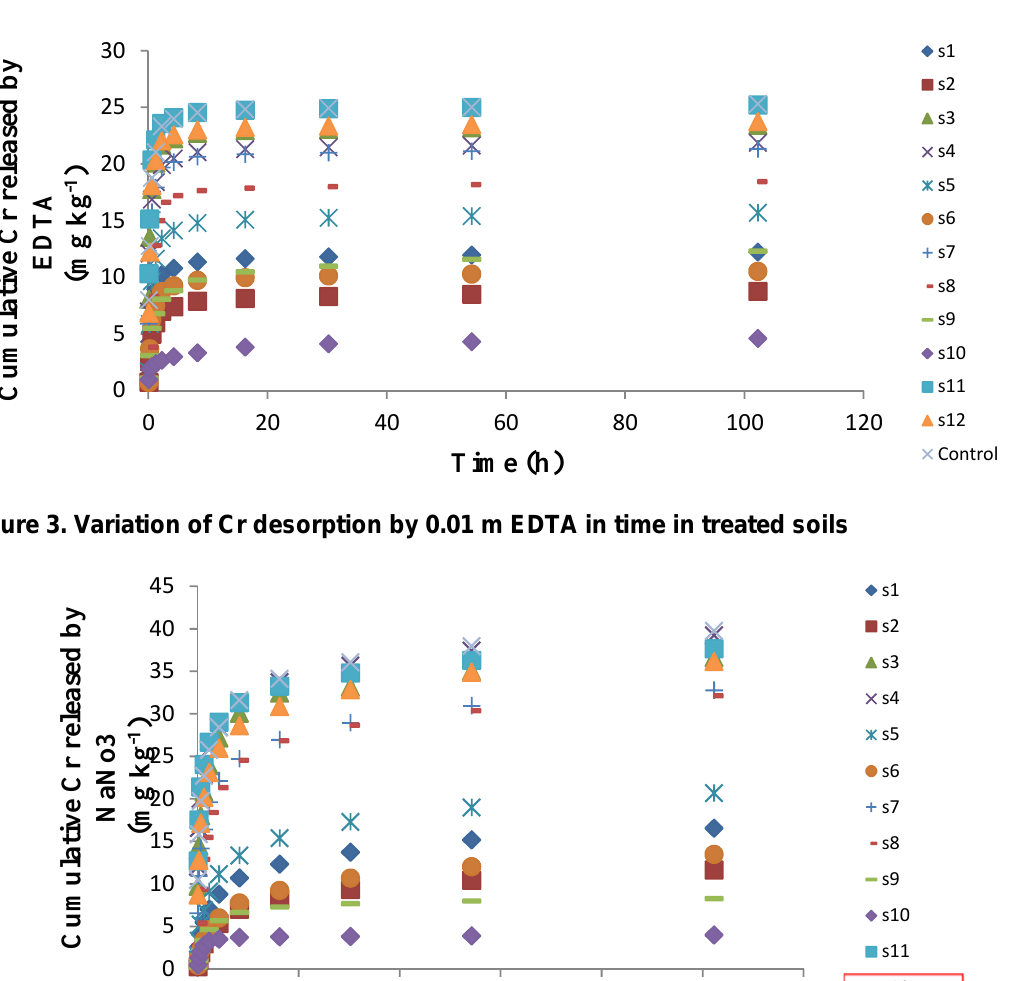
Figure 4. Variation of Cr desorption by 0.01 m NaNO